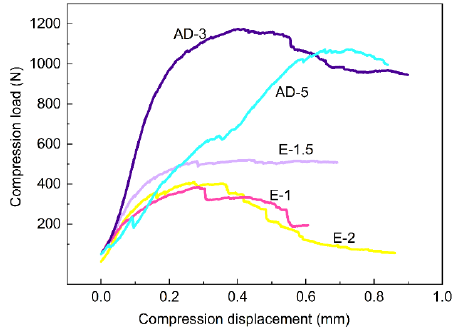
Figure 10. Load–displacement curves of SiCf/SiC composites containing SiCNWs.